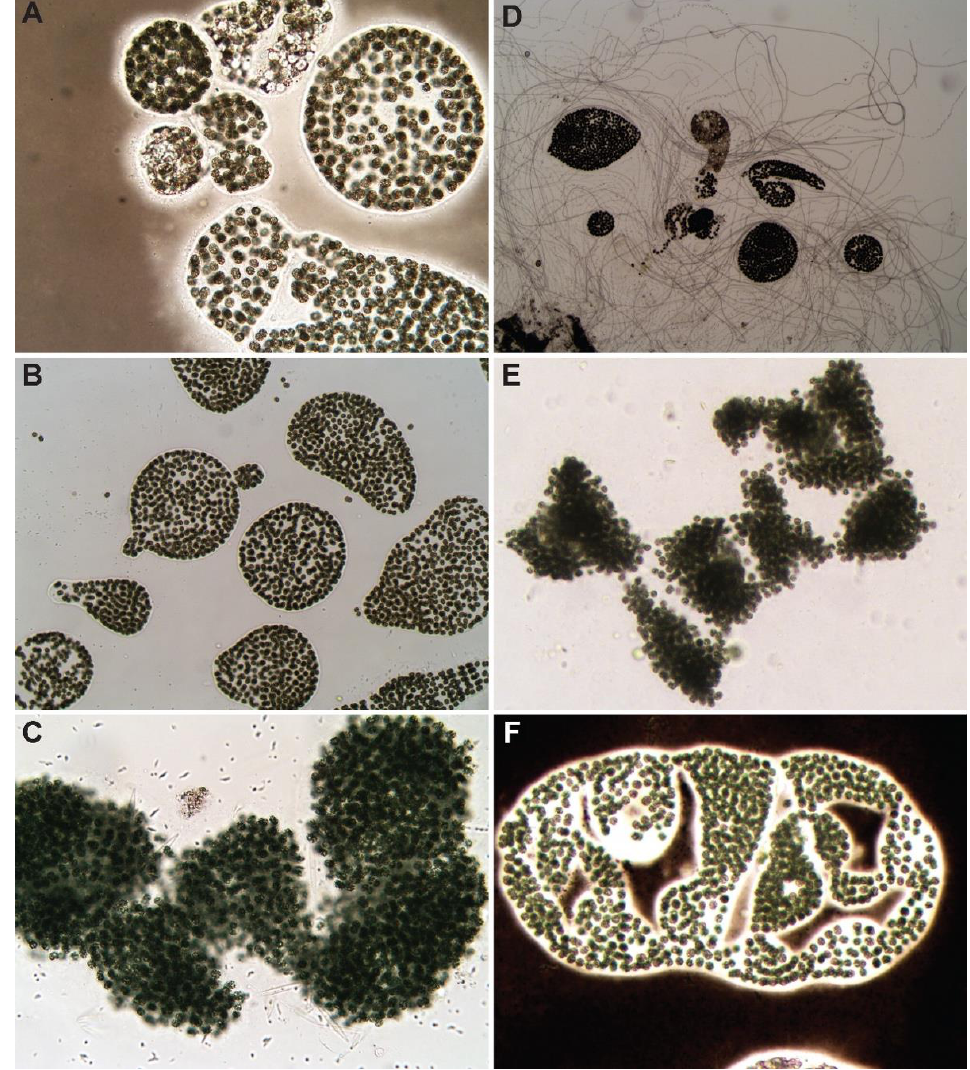
Figure 1. Microscopic images of the control at 0 h ( A – C ) and 72 h ( D – F ). ( A ) Microcystis wesenbergii colonies stained with ink, ( B ) M. wesenbergii colonies, ( C ) M. aeruginosa colony, ( D ) M. wesenbergii colonies with Pseudanabaena sp., ( E ) M. aeruginosa colony, and ( F ) M. wesenbergii colony stained with ink.